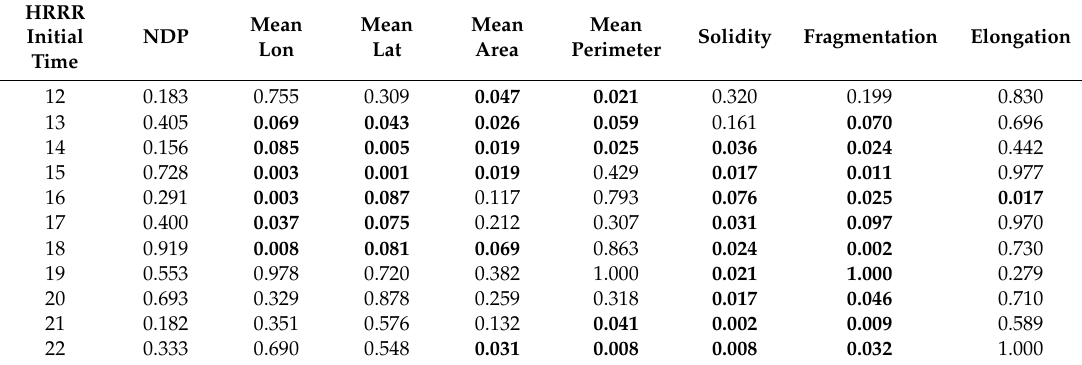
Table 2. Mann–Whitney U p -values for 0.254 mm h − 1 (0.01 in h − 1 ) threshold for Jul 31, 2016 case. Bold font face indicates significance at 90% confidence threshold.